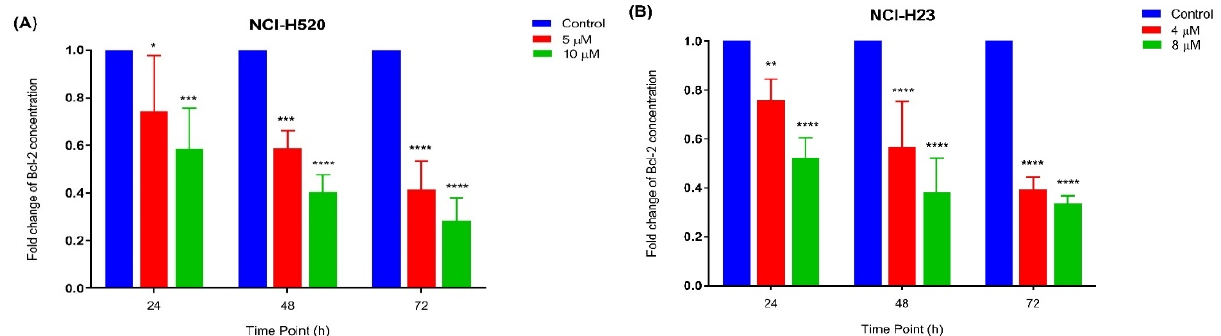
Figure 7. Fold change of Bcl-2 concentration in ( A ) NCI-H520 and ( B ) NCI-H23 cells treated with MS13 at different time points. Experiments were performed in triplicates and results compared between three independent experiments. Results are expressed as the ratio of means of Bcl-2 concentration of treated samples over untreated samples and comparison between datasets performed using ANOVA. Asterisks indicate statistically significant ( * for p < 0.05, ** for p < 0.01 *** for p < 0.001 and **** for p < 0.0001) differences between data sets for each treatment dose.